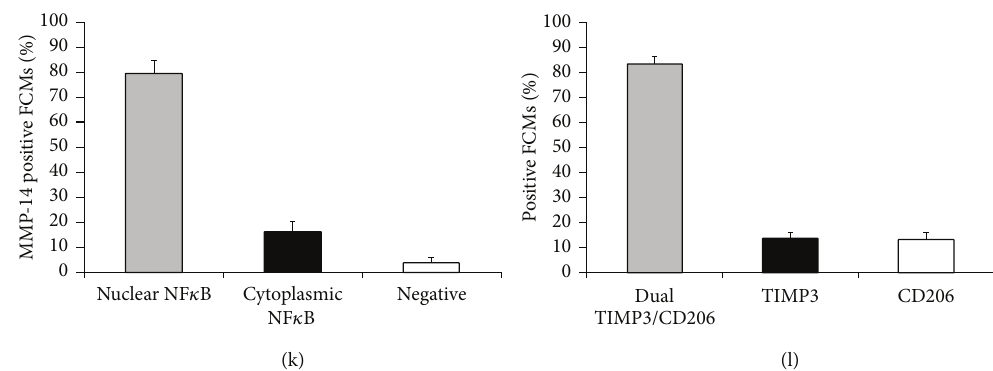
Figure 3: (a)–(j) Representative images of immunohistochemical labelling of unstable ((a)–(e)) and stable ((f)–(j)) human carotid artery atherosclerotic plaques, for macrophages (CD68, panels (a) and (f)), and colocalisation of nuclear-localised NF 𝜅 B with MMP-14 ((b)–(d)), and CD206 with TIMP-3 ((h)–(j)), with nuclei counterstained with DAPI (blue). Box in panels (a) and (f) represents higher magnification in panels (b)–(e) and (g)–(j), respectively. Scale bar in (a) represents 250 𝜇 m and is applicable to panels (a) and (f), whereas scale bar in (b) represents 100 𝜇 m and is applicable to panels (b)–(e) and (g)–(j). Arrows in panels (b)–(d) indicate MMP-14 +ve FCMs with nuclear NF 𝜅 B. Panels (e) and (j) represent negative controls where the primary antibodies were replaced with the relevant species IgG. (k) The percentage of MMP-14 positive FCMs that also stained for nuclear-localised NF 𝜅 B was significantly greater ( ∗∗∗ 𝑃 < 0.001 ) compared to only cytoplasmic NF 𝜅 B or no staining. (l) The percentage of TIMP-3 positive FCMs that stained also for CD206 was significantly greater ( ∗∗∗ 𝑃 < 0.001 ) compared to those stained for TIMP-3 or CD206 alone.